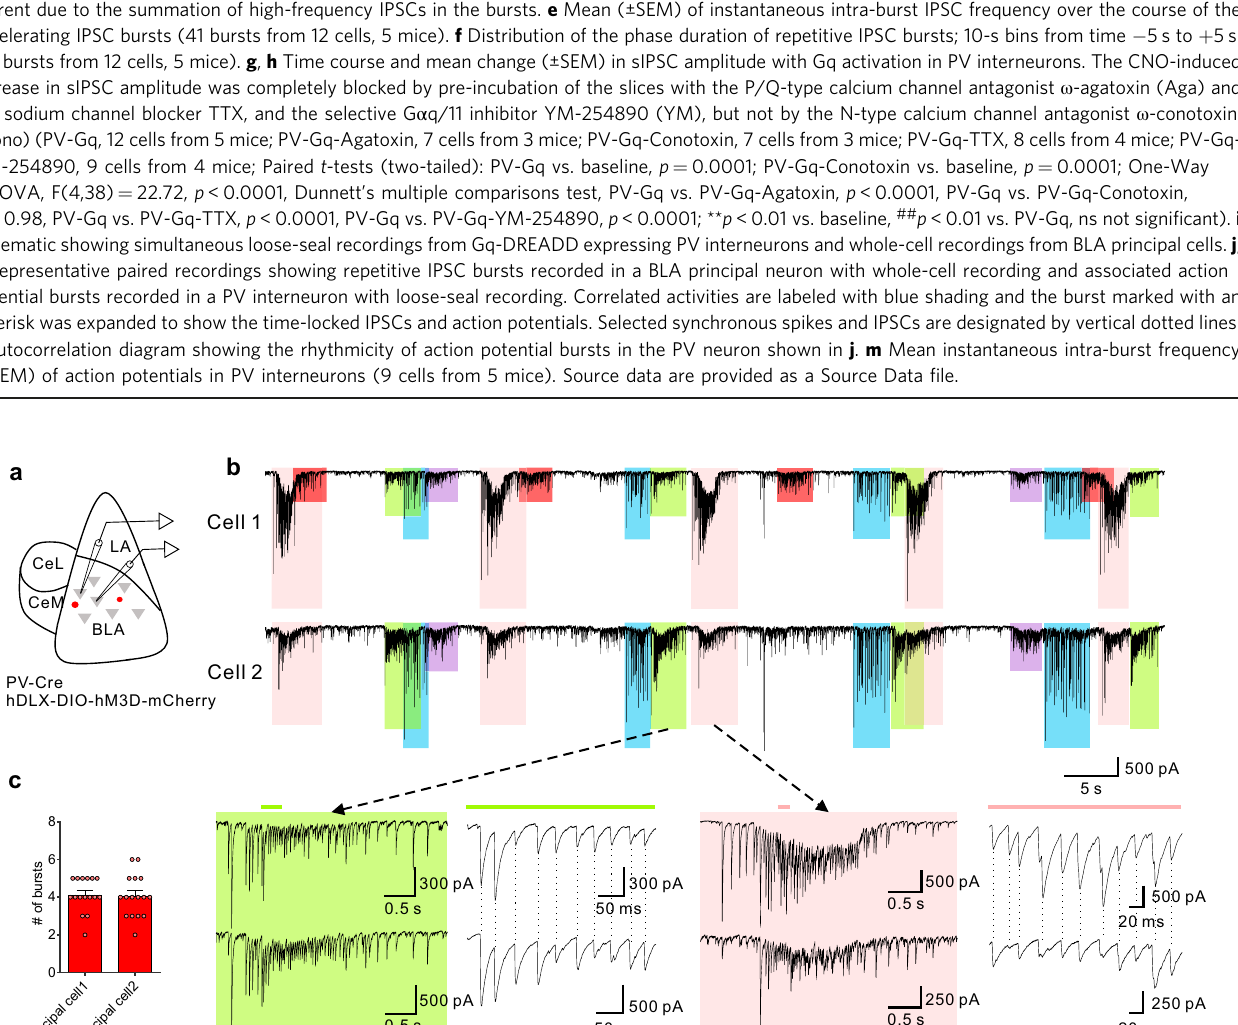
Fig. 1 Gq activation in PV interneurons stimulates patterned IPSC bursts in principal neurons. a Schematic of injection of conditional AAV expressing Gq-coupled DREADD (hM3D) in BLA of PV-Cre mouse. b hM3D-mCherry transduced in PV neurons is localized to GABA neurons of Gad67-GFP knockin mice (ten sections, 278 cells from 3 mice, ratio = 99.81%). Scale bar, 50 µ m. c Schematic showing whole-cell recordings of BLA principal neurons in Gq- DREADD-injected PV-Cre mice. d A representative recording in a BLA principal neuron showing the generation of phasic IPSC bursts by selective Gq activation in PV interneurons with bath application of CNO. Dashed arrows designate expanded traces of individual bursts to illustrate different stereotyped IPSC bursts (color-coded) at two successive time points. The dashed lines in the expanded traces show the depressed baseline of the holding